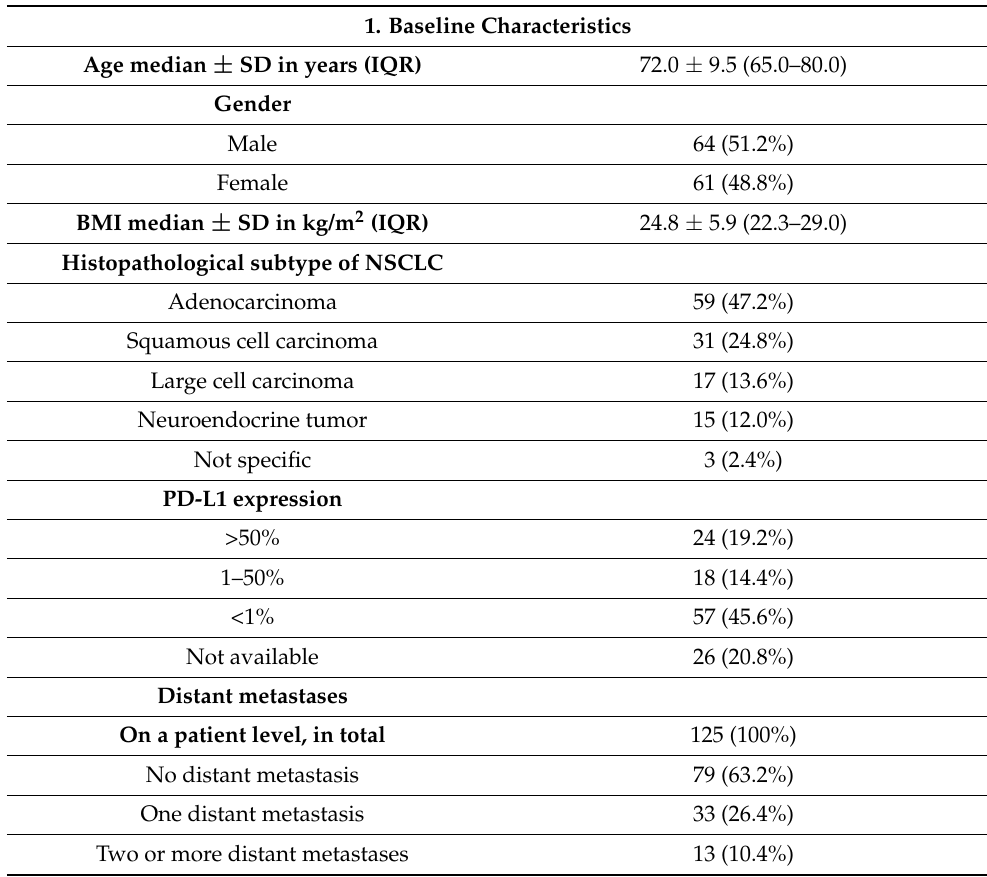
Table 1. Baseline characteristics of all the included NSCLC patients (N = 125) before initiating